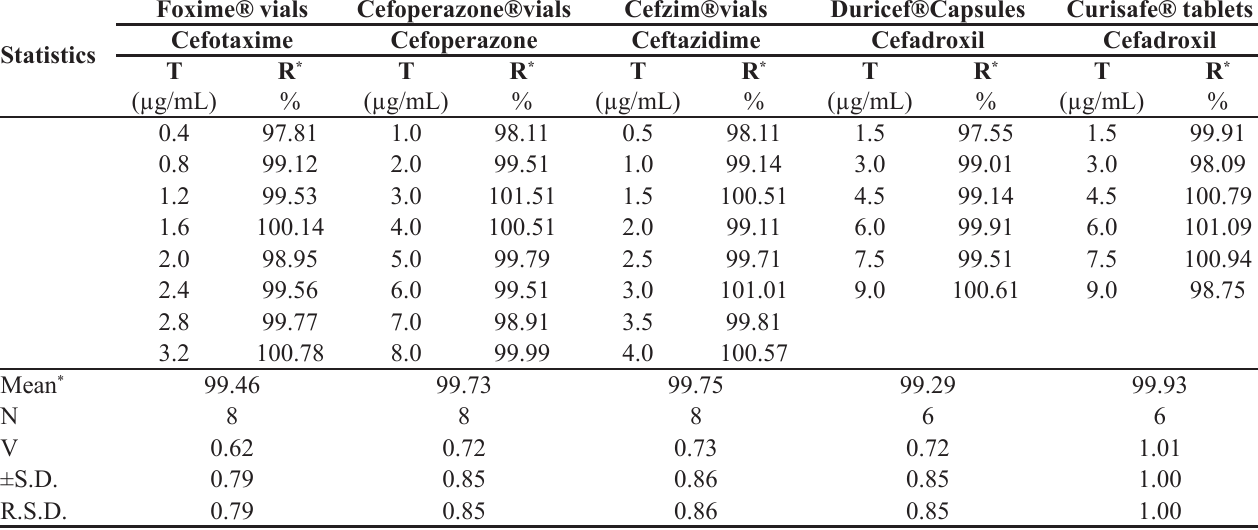
TABLE IV - The determination of cefotaxime, cefoperazone, ceftazidime and cefadroxil in their pharmaceutical formulations